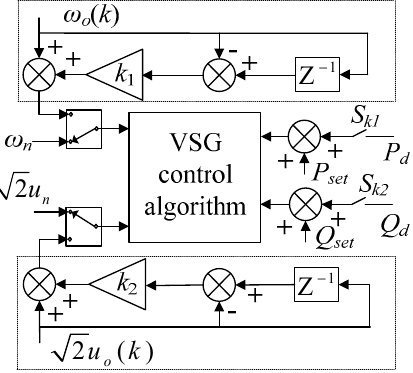
Figure 9. Schematic diagram of the islanding detection.